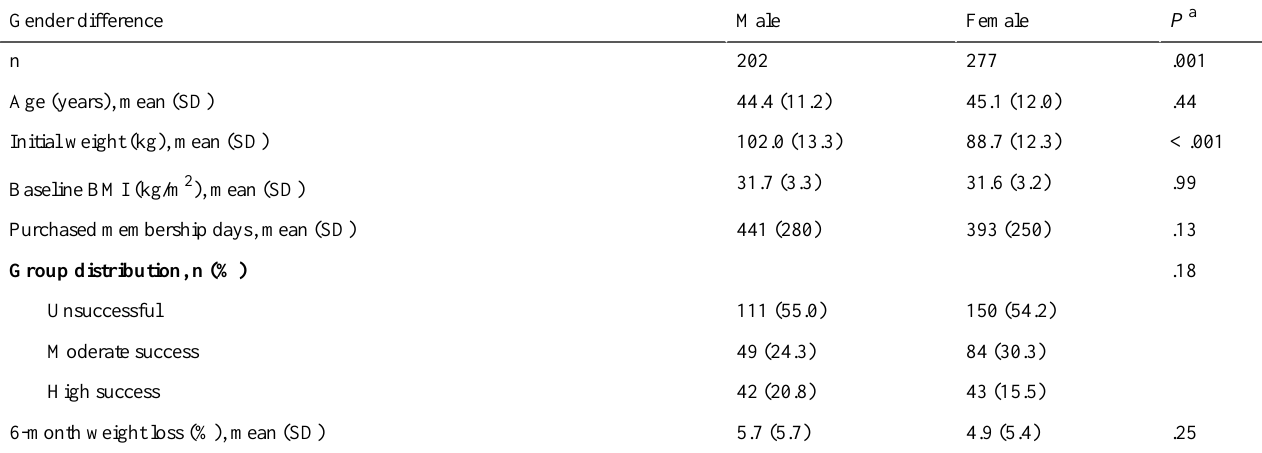
Table 4. Gender differences of the study sample.